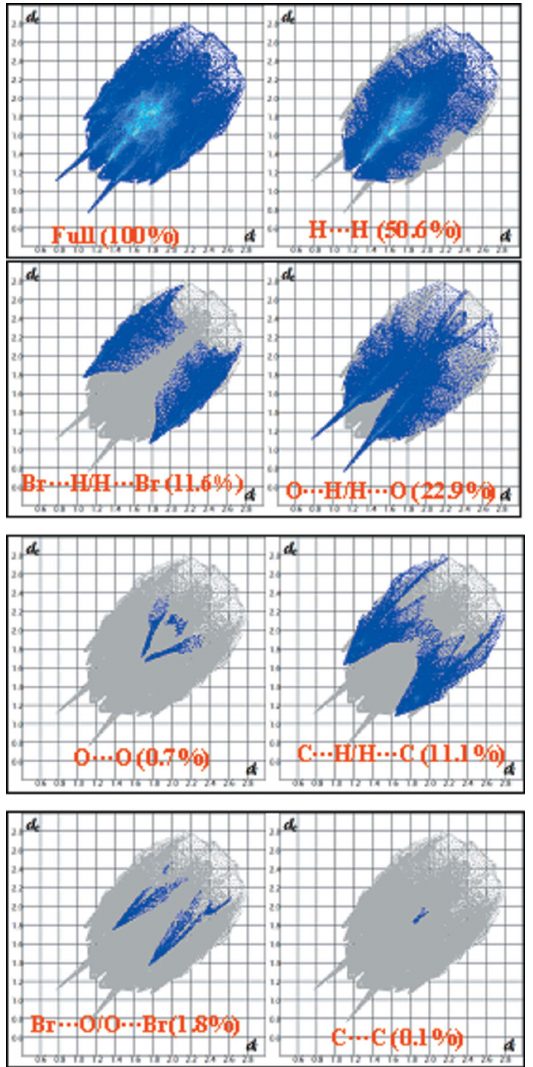
Figure 6 The percentage contributions of close contacts of (I). The d i and d e values are the closest internal and external distances (in A˚ ) from given points on the Hirshfeld